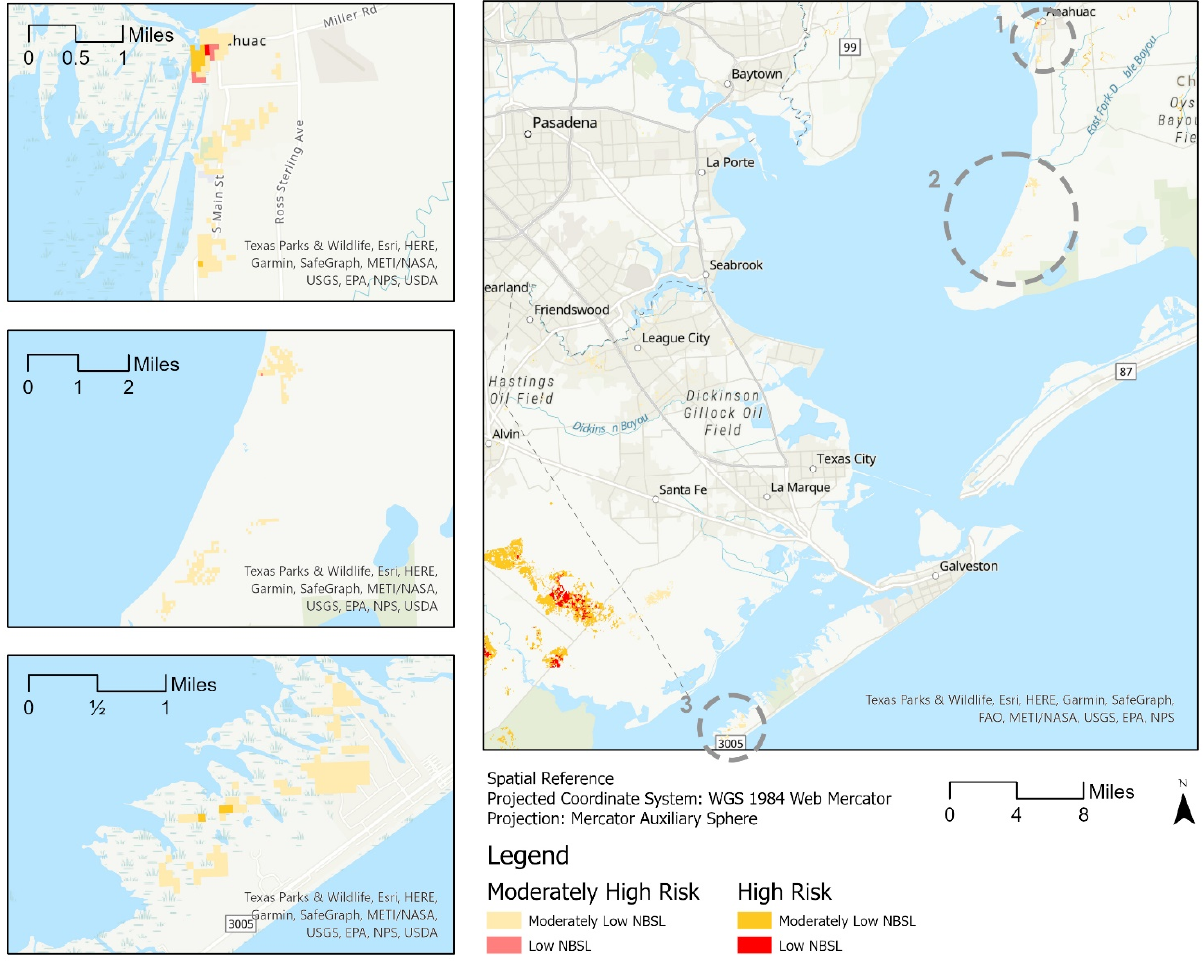
Figure 4. Close-ups of the three identified communities (Anahuac, Smith Point, Jamaica Beach) in relation to the whole study area that are most vulnerable to flooding due to having low to moderately low NBSLs with moderately high to high relative ES risks.